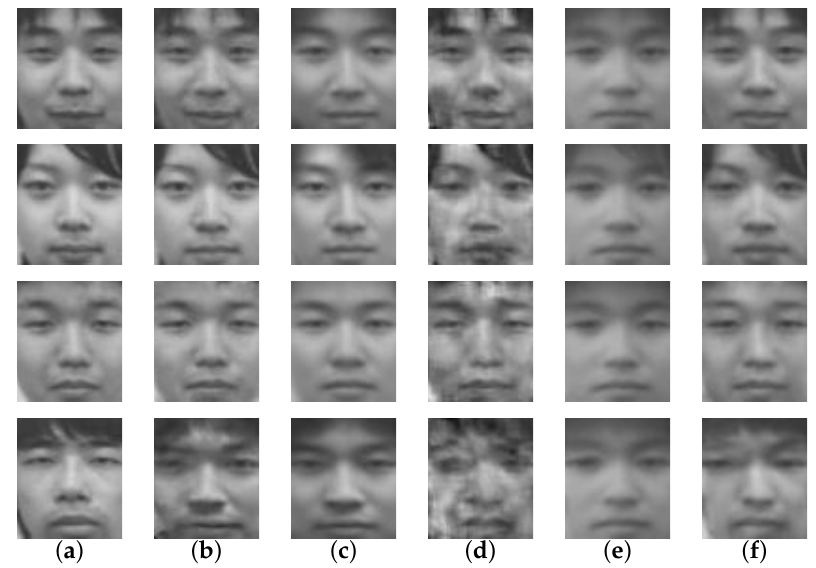
Figure 4. Examples of reconstructed images by various methods. Each row indicates a person and the columns represent images of: ( a ) ground-truth; ( b ) proposed method; ( c ) holistic LLE (Locally Linear